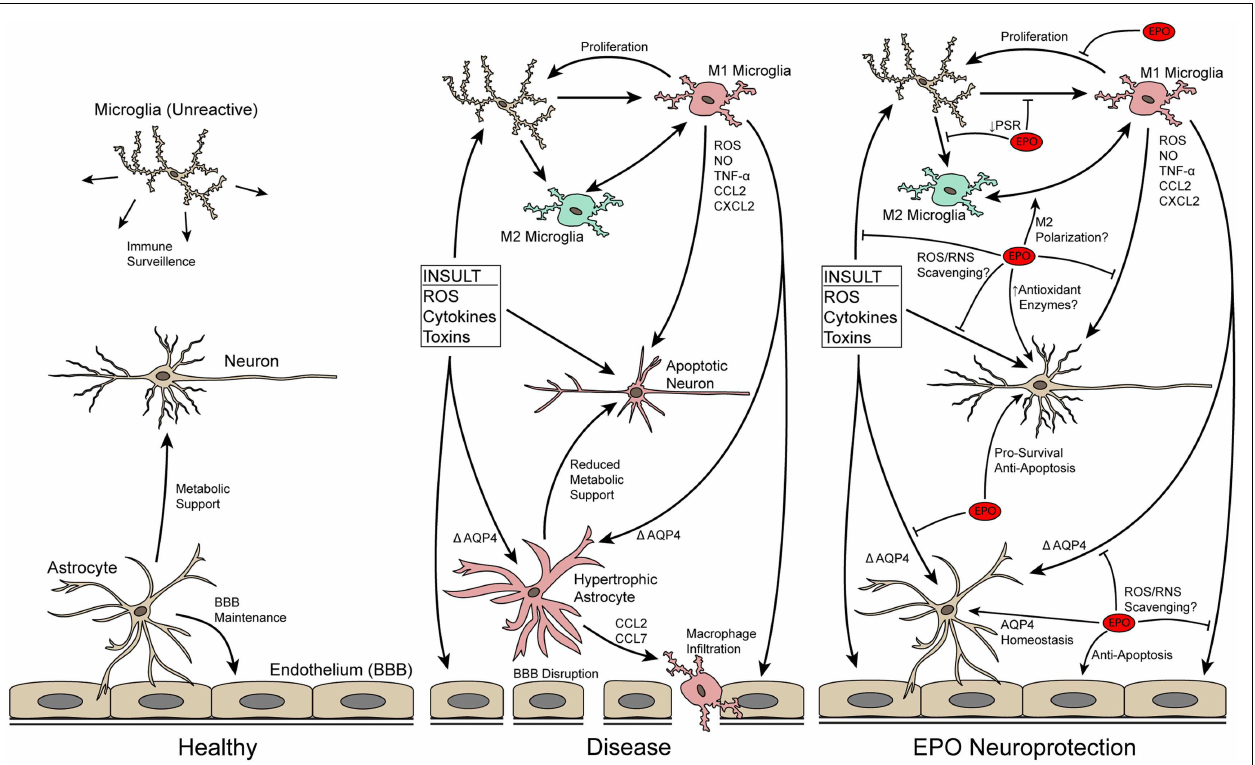
undergo apoptosis. EPO directly blocks apoptosis of neurons and preserves the BBB by blocking apoptosis of endothelial cells and decreasing astrocyte hypertrophy, thus, decreasing infiltration of immune cells. In addition, EPO may directly scavenge ROS/RNS to reduce local oxidative stress. EPO also has a direct effect on microglia, affecting their proliferative capability and possibly influencing their M1/M2 reactive